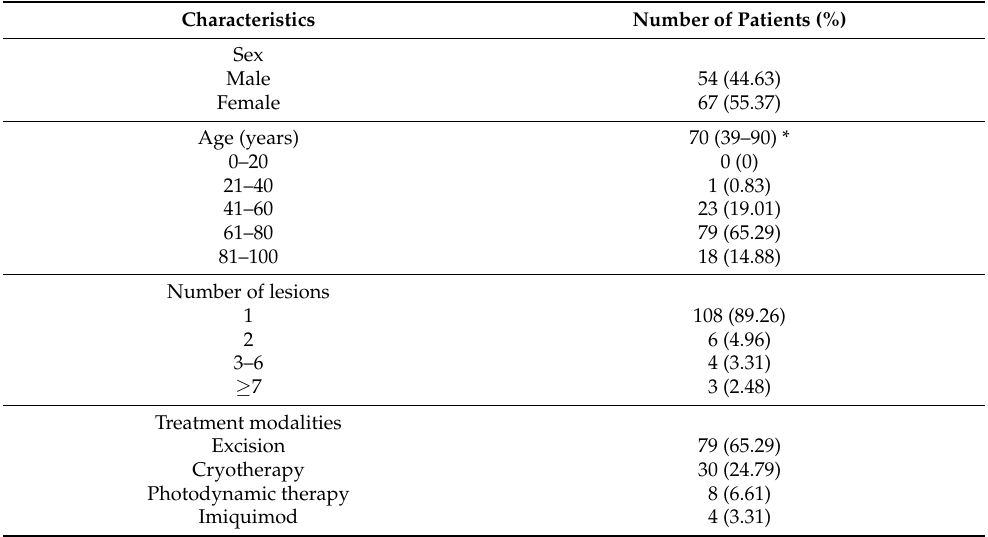
Table 1. Demographic and clinical characteristics of the patients.